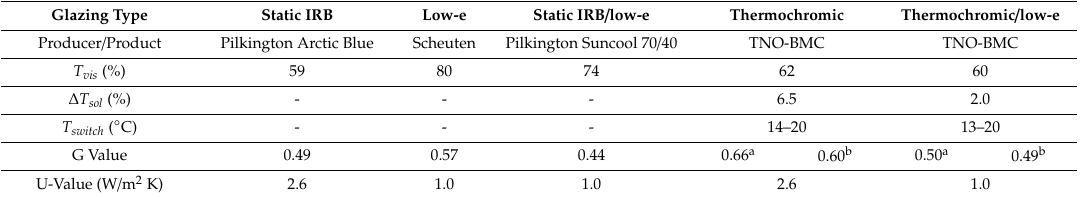
Table 1. Solar properties, G and U-values of all double glazing units used in this study.